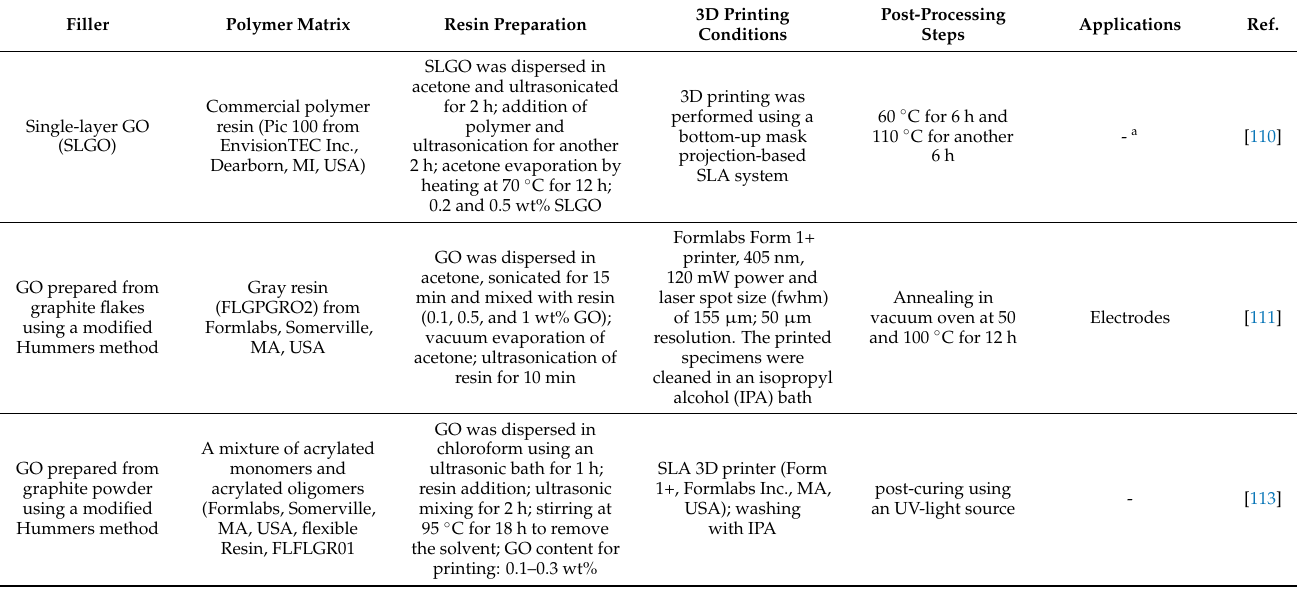
Table 2. The representative 3D-printed graphene/GO-based